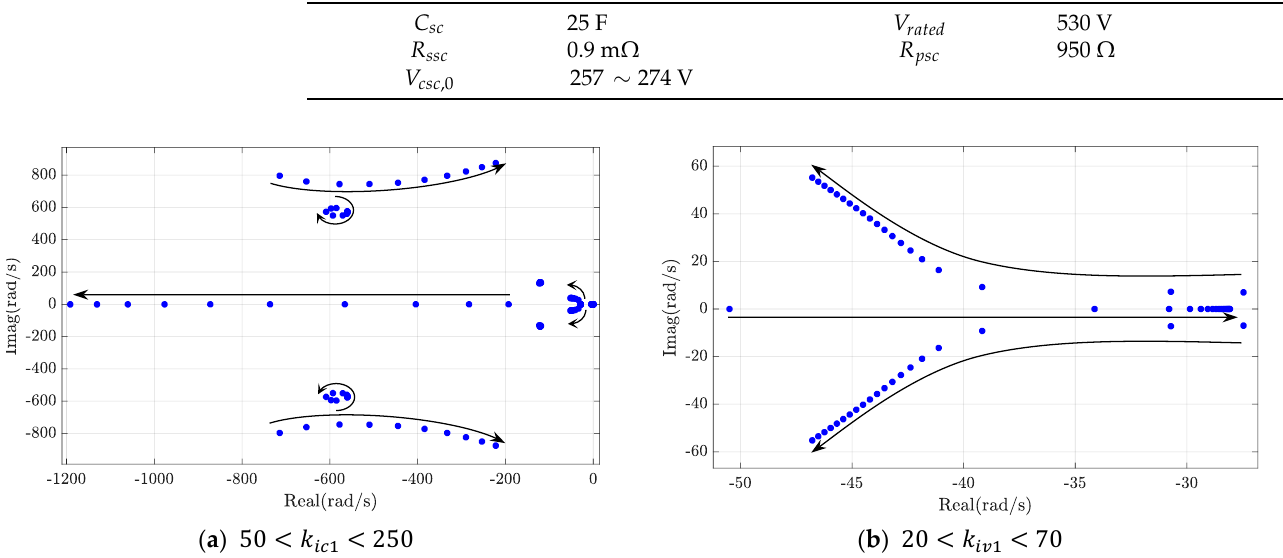
Figure 16. Pole map of the PVSC small-signal model for the variation of DC-DC control system parameters: ( a ) variation of and ( b ) variation of . of k ic 1 and ( b ) variation of k iv 1 𝑘𝑘 𝑖𝑖𝑝𝑝1 𝑘𝑘 𝑖𝑖𝑠𝑠1